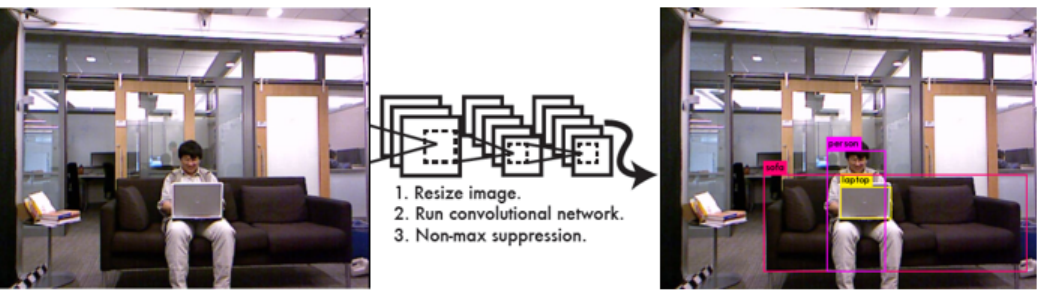
Figure 3. The YOLO detection system. (1) resizes the input image to 448 × 448; (2) runs a single convolutional network on the image; and (3) thresholds the resulting detections by the model’s